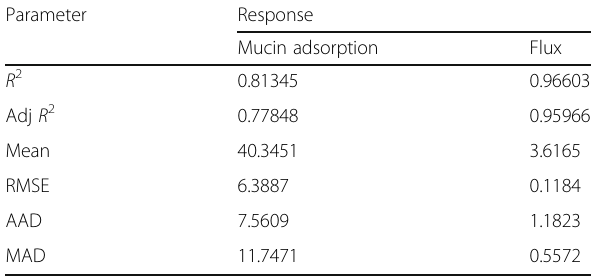
Table 4 Goodness of fit statistics for ANN